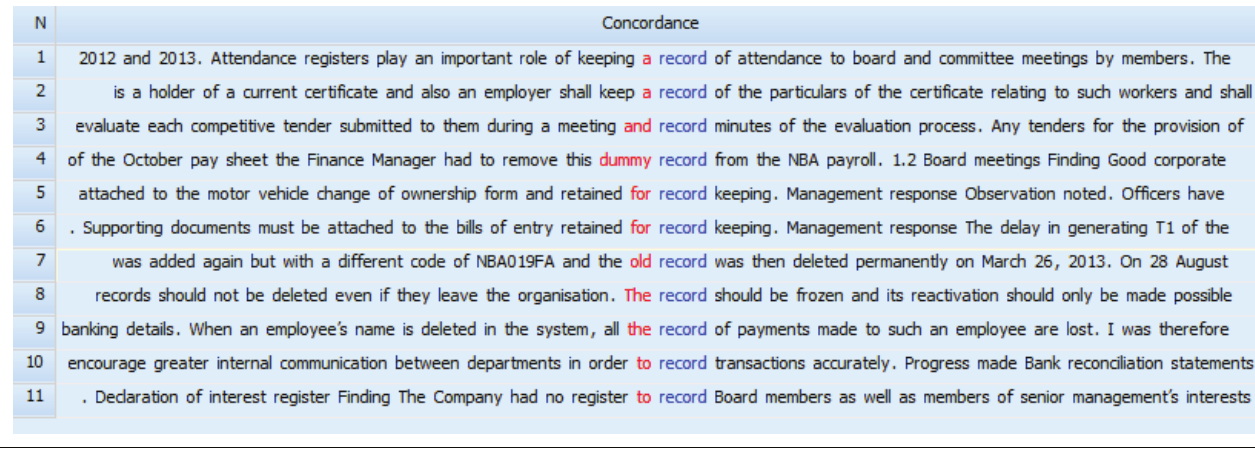
FIGURE 8: The Comptroller and Auditor General of Zimbabwe Narrative Report for the financial year ended 31 December 2014 for state enterprises and parastatals.